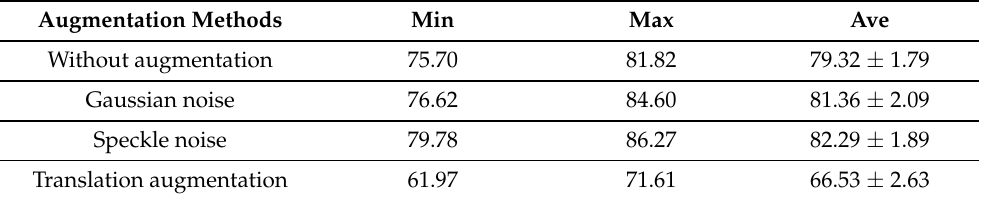
Figure 9. Illustration of data augmentation operations. ( a ) Image of 2S1 category. ( b ) Gaussian noise augmentation. ( c ) Speckle noise augmentation. ( d ) Translation augmentation. Table 4. Training Scenario II: recognition results of different data augmentation methods